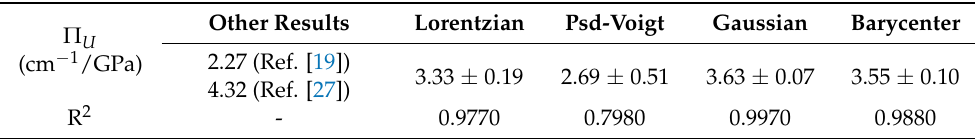
Table 4. Piezospectroscopic coefficients Π U from calibration experiments, obtained with different data processing